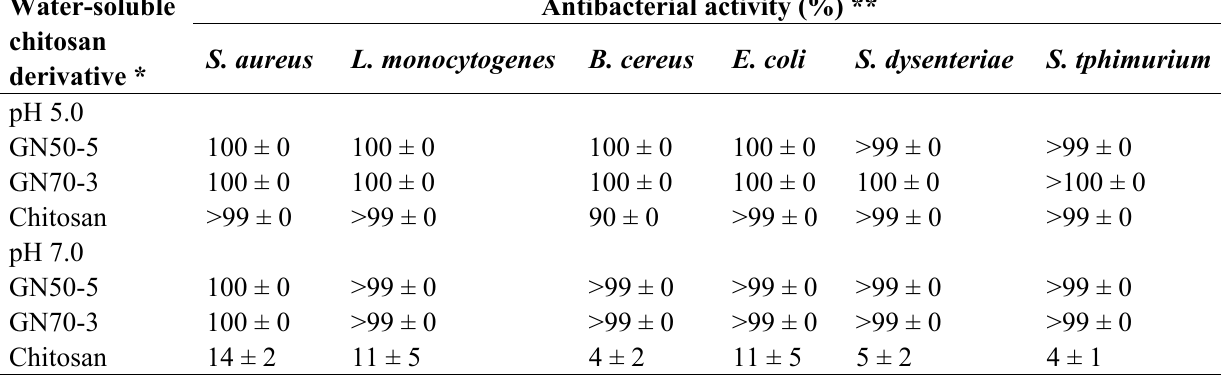
Table 1. Effect of pH on the antibacterial activity of the water-soluble chitosan derivatives in nutrient